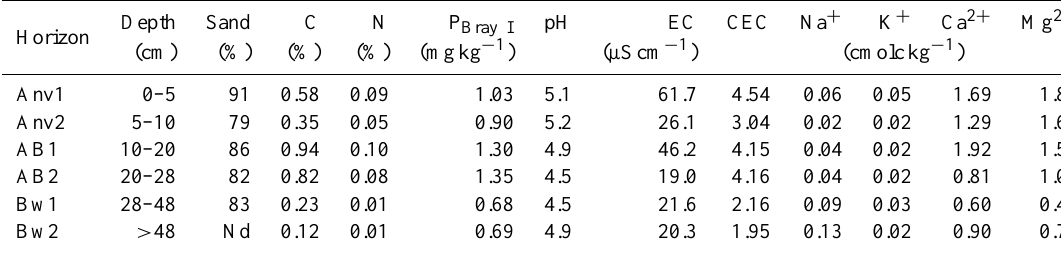
Table 1. Characteristics of the novic Arenosol profile in Gunung Kleng. Depth Horizon